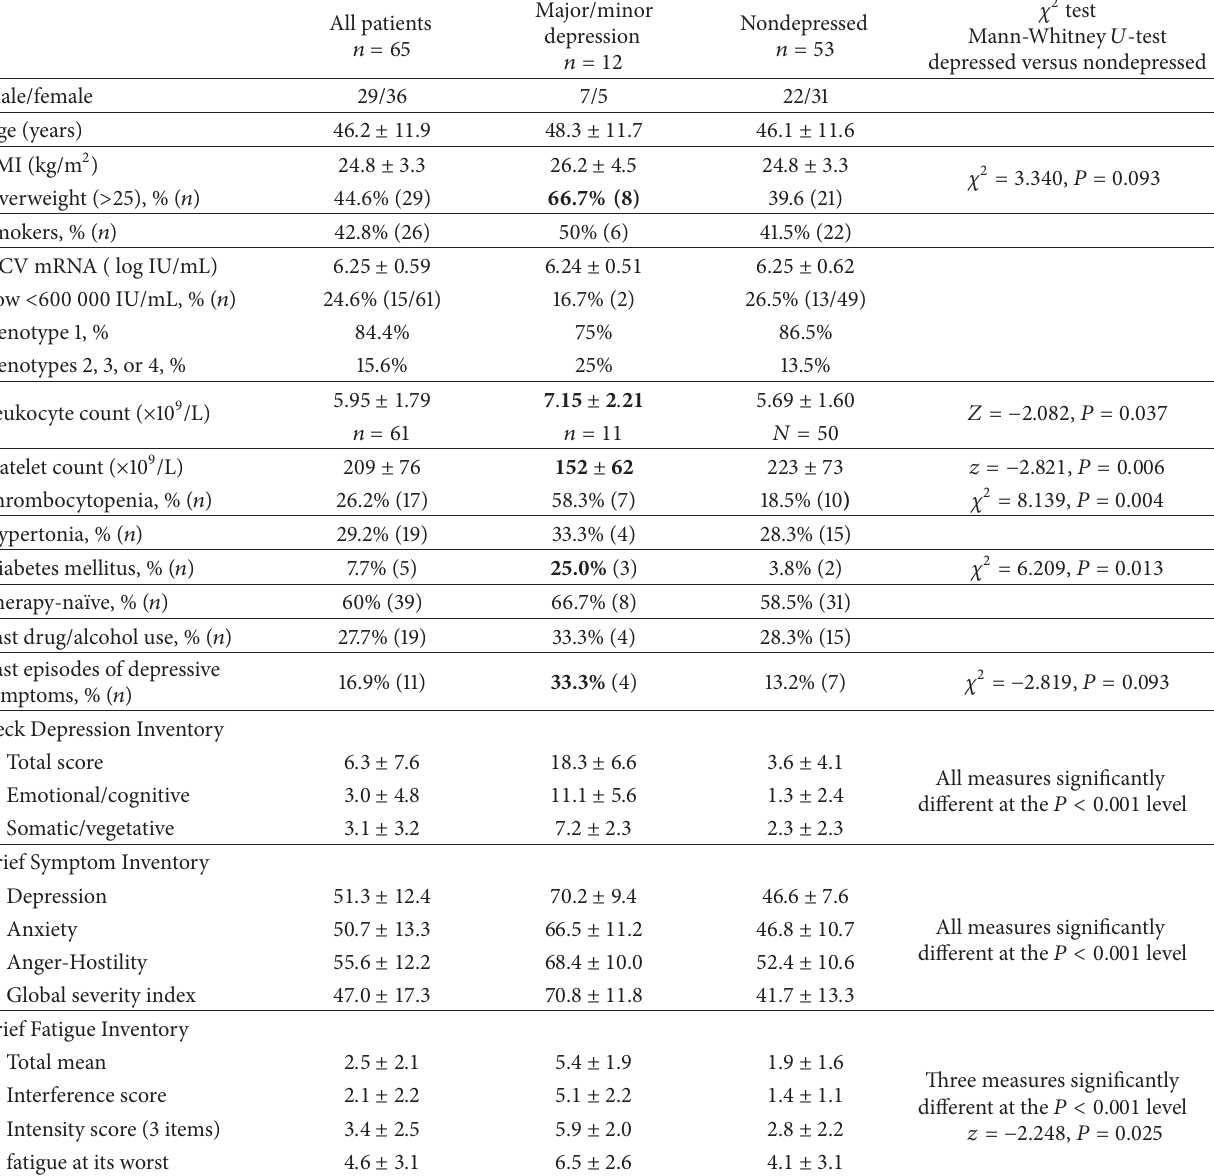
Table 1: Demographic and clinical characteristics of patients with chronic